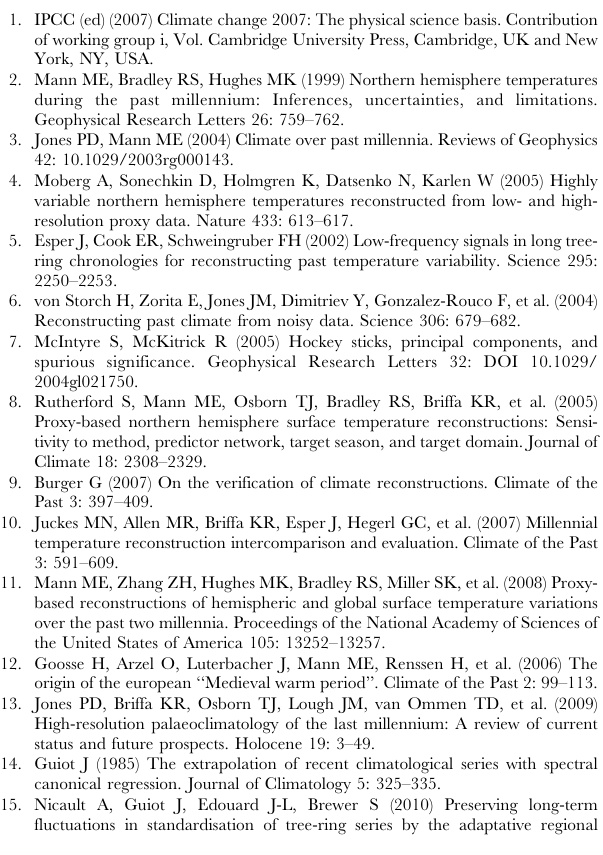
anomalies in four quarters of Europe and for the whole continent (the quarters are divided by the 45 u N parallel and the 20 u E meridian). In orange, the observations; in black the reconstruction with its shaded 95%-confidence interval; in blue the trend of the reconstruction and in red the trend of the observations. Found at: doi:10.1371/journal.pone.0009972.s017 (1.56 MB TIF) Figure S11 Distribution of the correlations between each proxy and the reconstructed temperature series. The proxies were sorted by decreasing order of maximum correlation (in absolute value) and only the proxies with significant correlations are presented. Two scales of correlations are used: for the first seven maps scale from 2 0.5 to 0.5 and for the others series, scale from 2 0.3 to 0.3 applies. Found at: doi:10.1371/journal.pone.0009972.s018 (2.26 MB